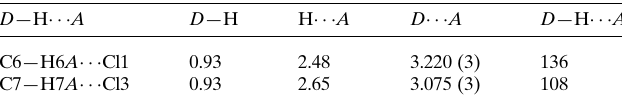
Table 2 Summary of short interatomic contacts (A˚ ) in the title